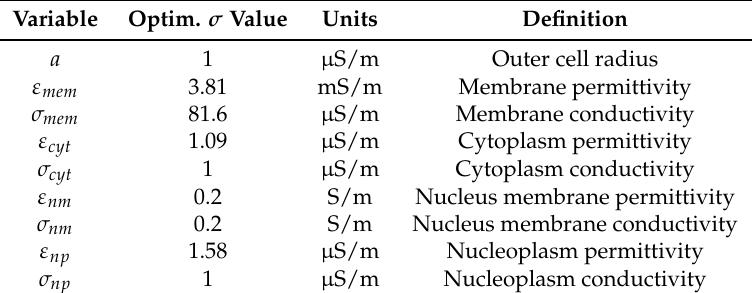
Figure 1. The average variation in the DEP force, ∆ F DEP , that arises from variations in radius and other electrical parameters in a 4-shell model for HEK cells. Model parameters are given in Table 1. Table 2. Optimized media conductivity values to maximize the variation in ∆ F DEP in response to changes in cell model electrical